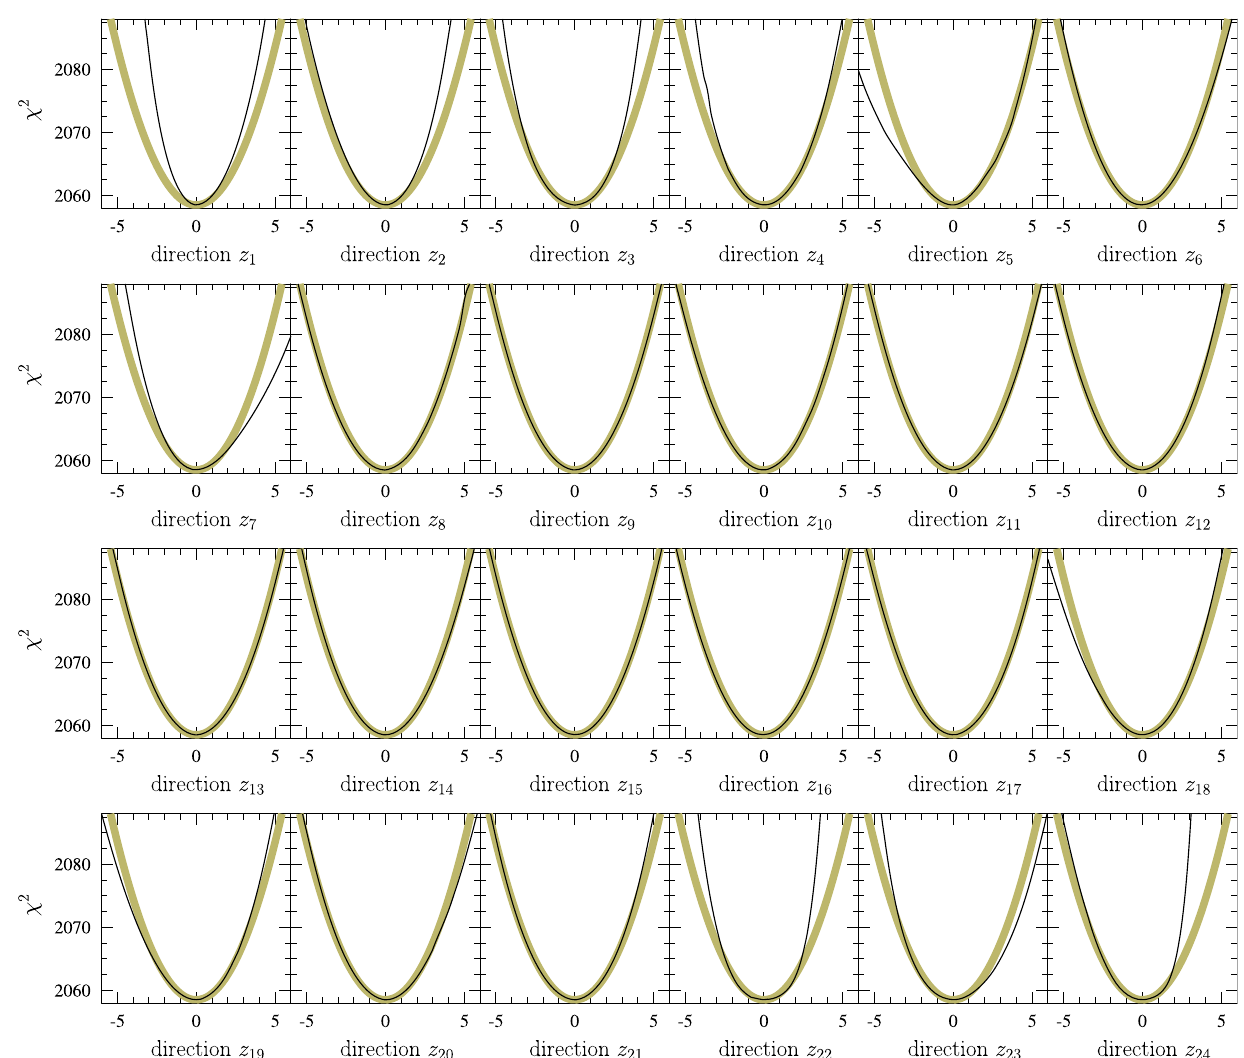
+ z 2 (thicker curves) i 0